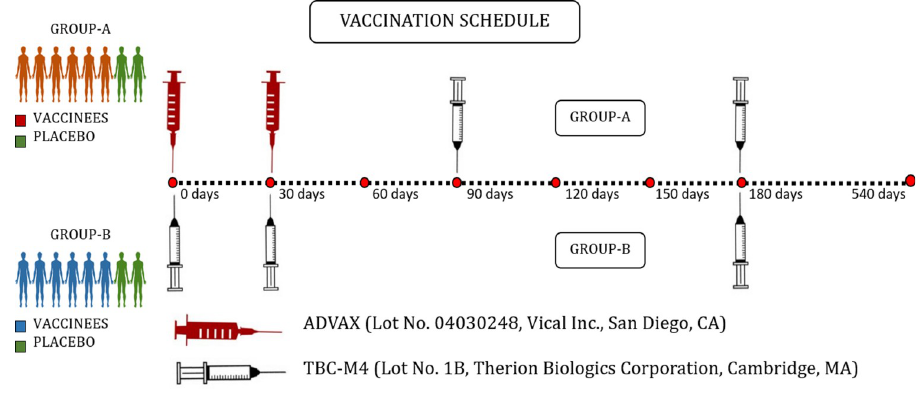
Fig 1. Vaccination schedule of IAVI Phase-I Prime Boost HIV-1 Subtype-C Prophylactic Vaccine Trial- NIRT-ICMR (P001 Trial).